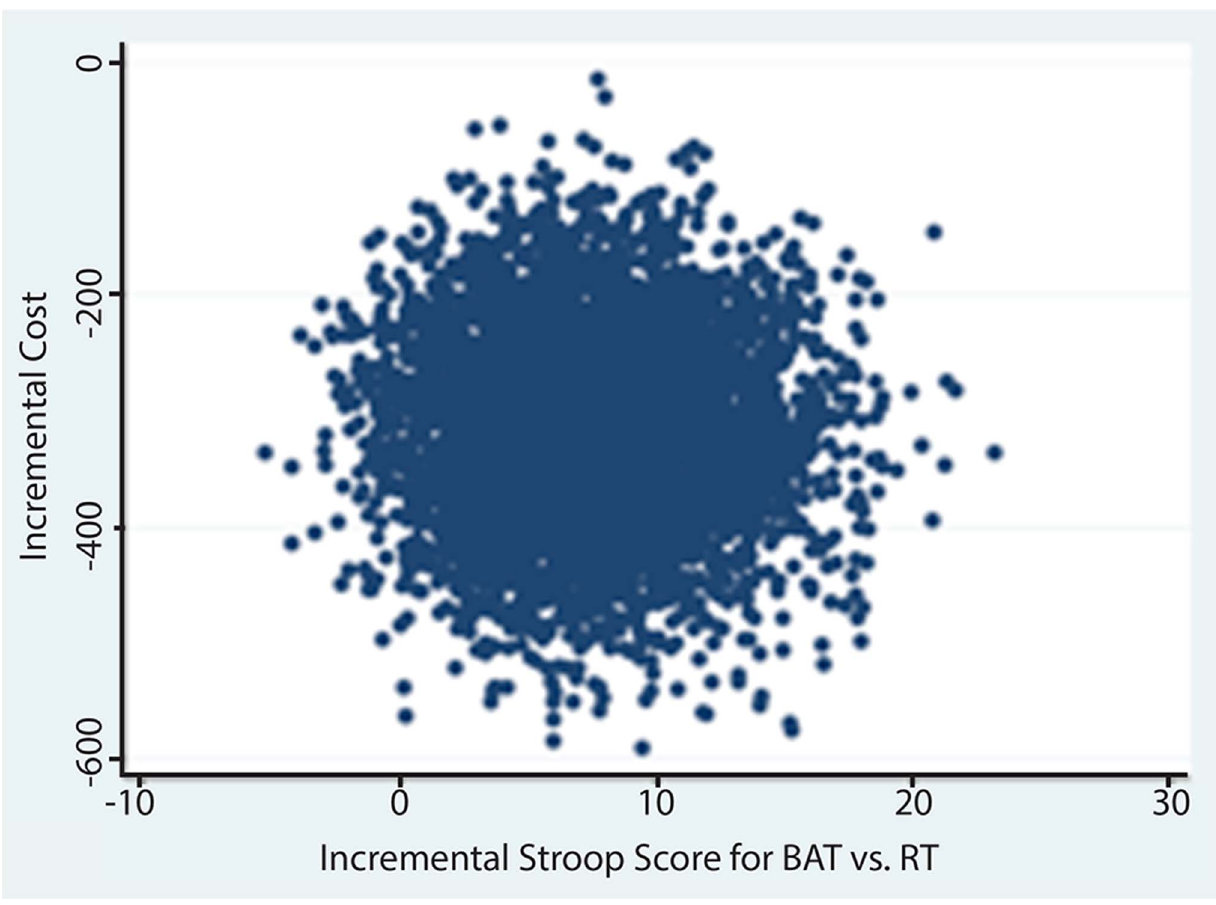
Figure 2. Cost effectiveness plane depicting scatterplot of bootstrapped estimates of incremental cost and effectiveness for comparison between RT and BAT.